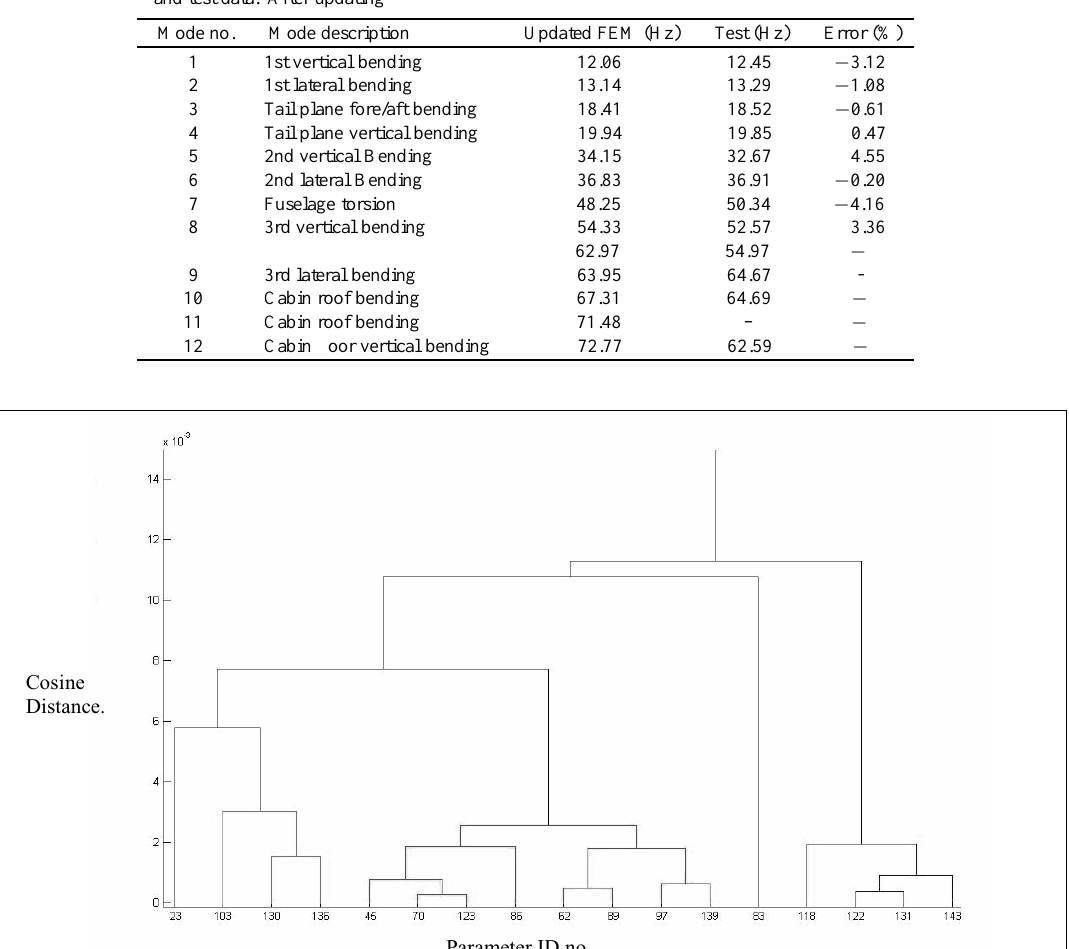
Table 4 Predicted natural frequencies (Hz) and errors (%) between the finite element model (base line)